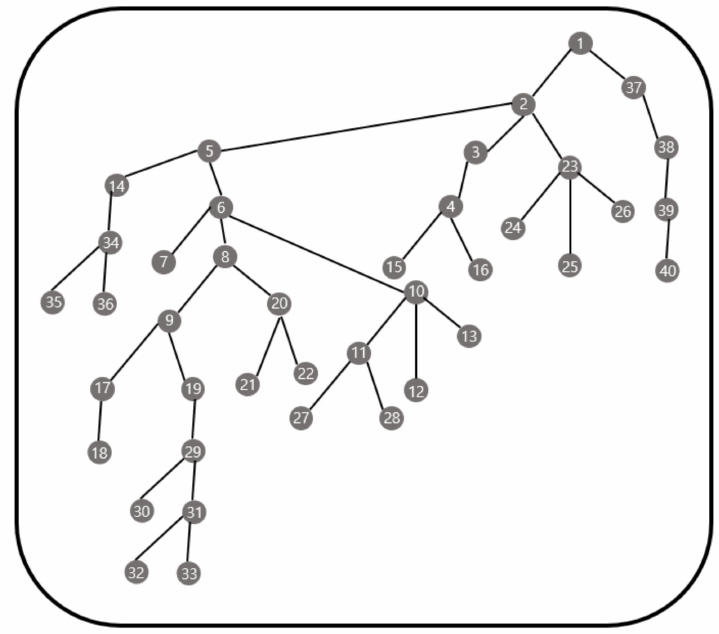
Figure 14. Topology of 40 sensor nodes.